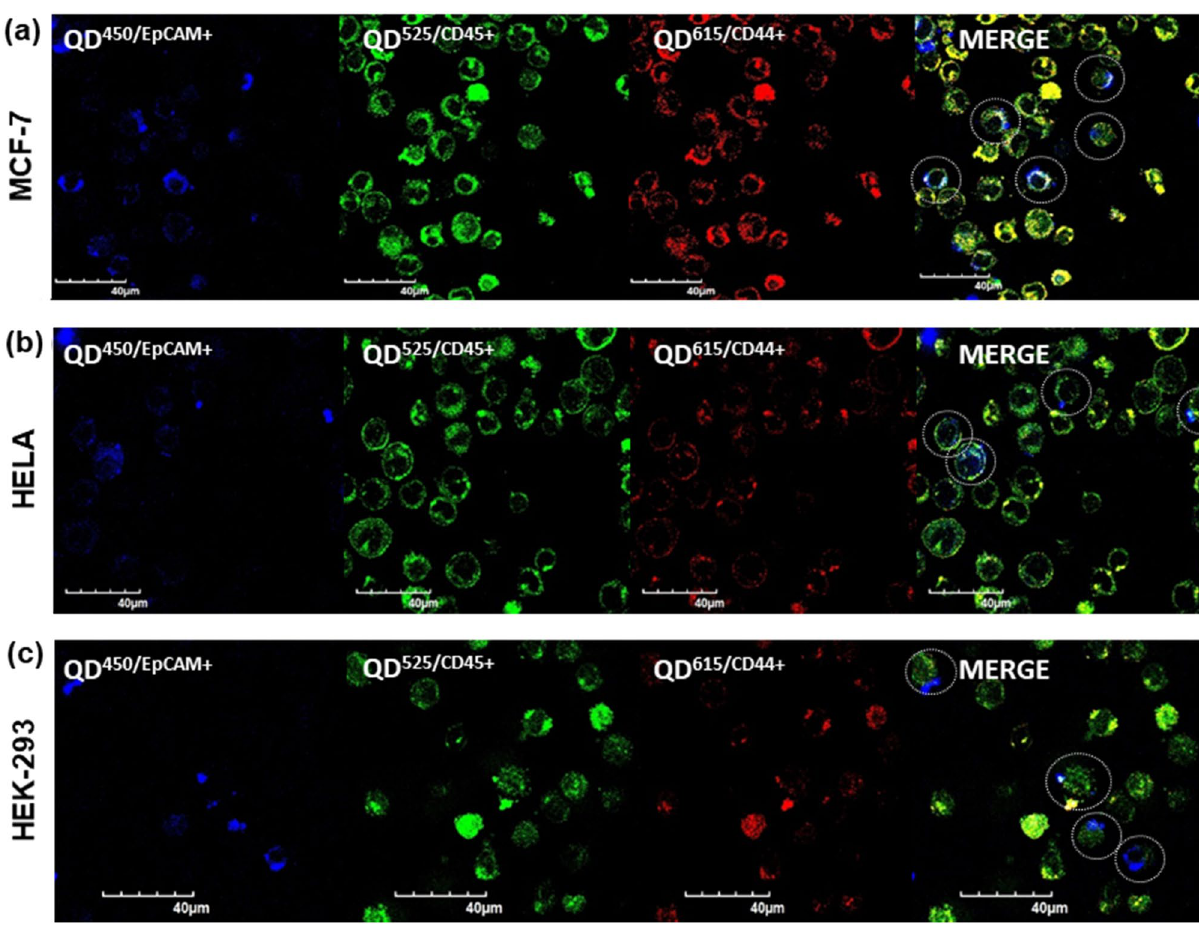
Figure 6. Confocal microscopic images for capture the EpCAM+ and EpCAM− cells by using the quantum dot conjugated with anti-EpCAM, anti-CD45, and anti-CD44 cells in co-culture cells in in-vitro incubated with concentrations at 1.0 μg/mL in 1 × PBS media were analyzed through confocal imaging ( a ) MCF-7 and THP-1 ( b ) HeLa and THP-1 ( c ) HEK-293 and THP-1 cancer cell lines co-cultures with fluorescence emissions shows the confocal images with respective Quantum dots binding, which are represented with dotted